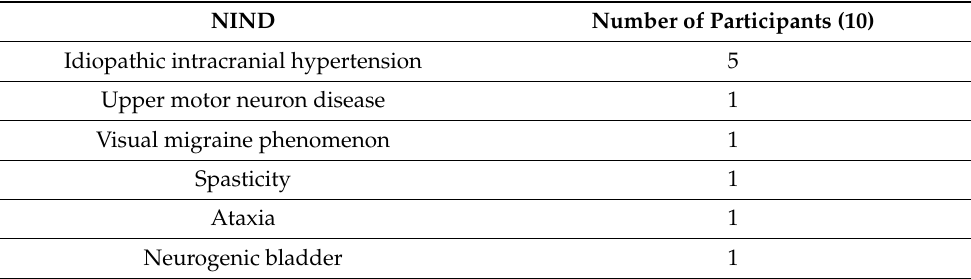
Table 2. Participant noninflammatory neurological disorders (NIND).